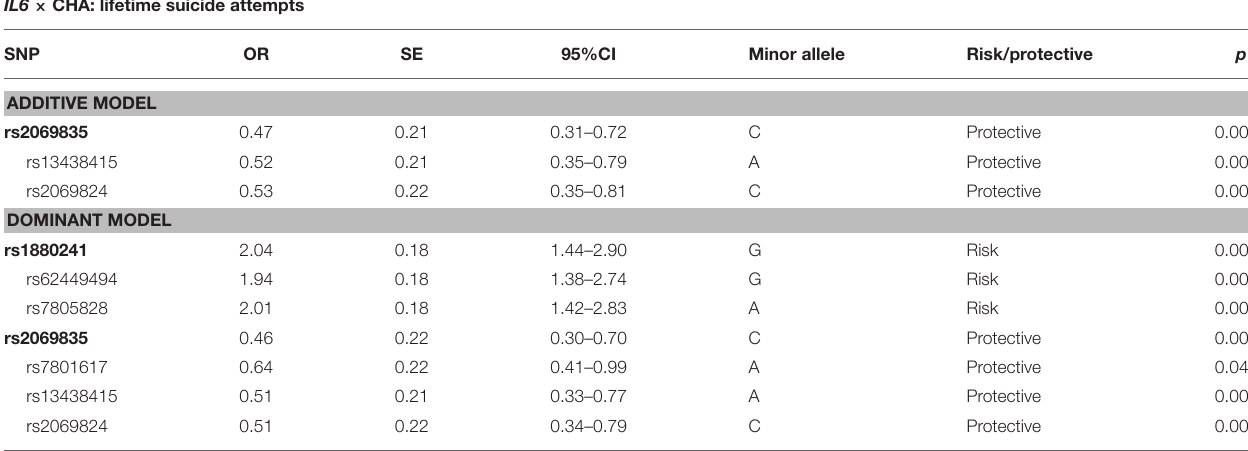
TABLE 2 | Interaction effects between IL6 variation and childhood adversities on lifetime suicide attempts.